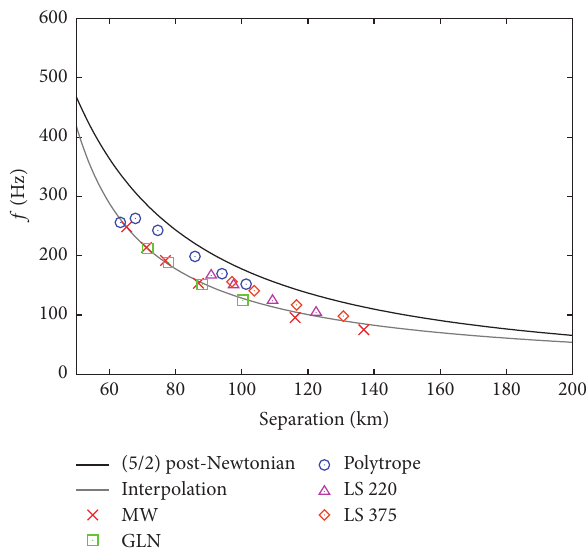
r a n t C e Figure 8: Plot of the central density, 𝜌 𝑐 , versus the number of orbit. The solid lines from top to bottom are for 𝐽 = 3.0, 3.2, 3.4, 3.6, 3.8, 4.0 × 10 11 cm 2 .